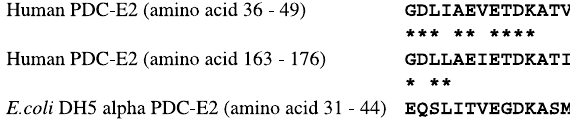
Figure 1. Amino acid sequence homology between human PDC- E2 and homologs from E. coli DH5 alpha. It is of note that the human sequences are also included in the triple expression hybrid pMIT3 that was used herein for